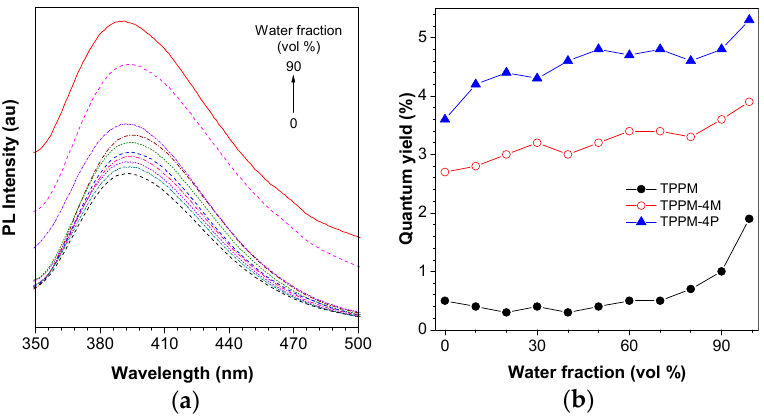
Figure 2. ( a ) PL spectra of TPPM in THF/water mixtures with different water fraction. Concentration: 10 − 5 M, λ ex = 300 nm; ( b ) Fluorescence quantum yields of TPPM and its derivatives vs. water fraction in THF/water mixtures.